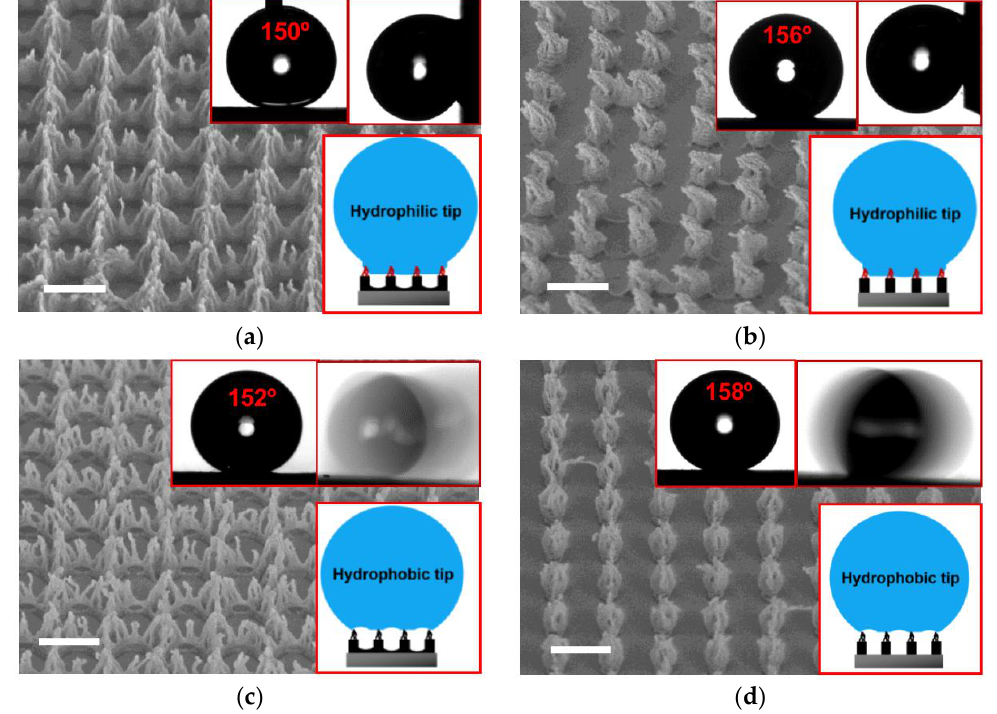
Figure 3. SEM images of hierarchical polymer nanostructures obtained with the oxygen plasma etching for 180 s ( a , c ) and 420 s ( b , d ), followed by the spin-coating of PTFE ( a , b ) and the SAM-coating of FDTS ( c , d ), respectively. The scale bar in each SEM image represents 1 µm. Insets in each image show the measurements of CA and CAH/SA, as well as the schematics of the wetting states.